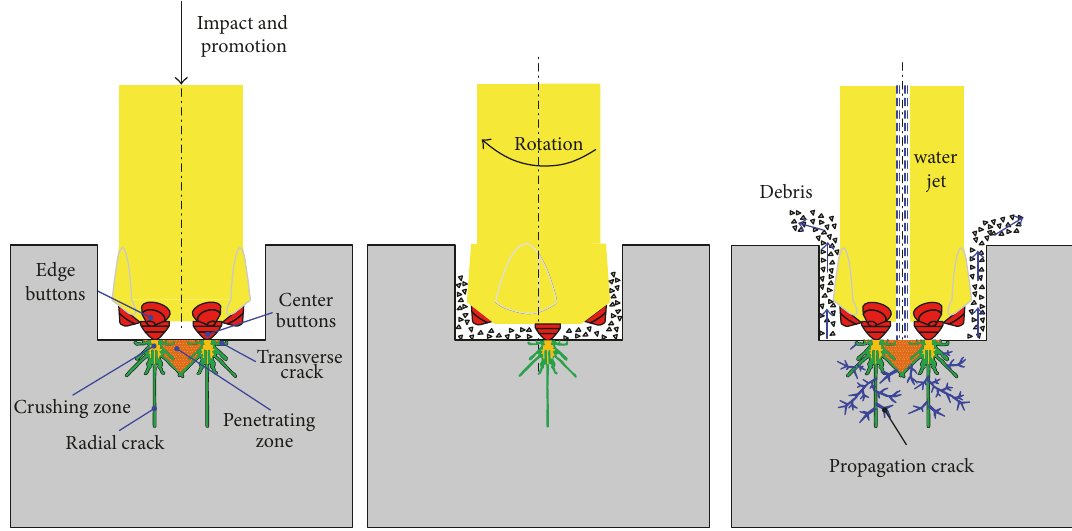
Figure 1: Fragmentation mechanism of drilling assisted with water